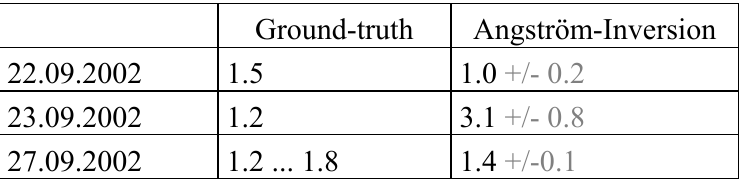
Table 10. Results for validation of Angström-Exponent estimation +/- : Variation over 5x5-Pixel ground-truth area on the